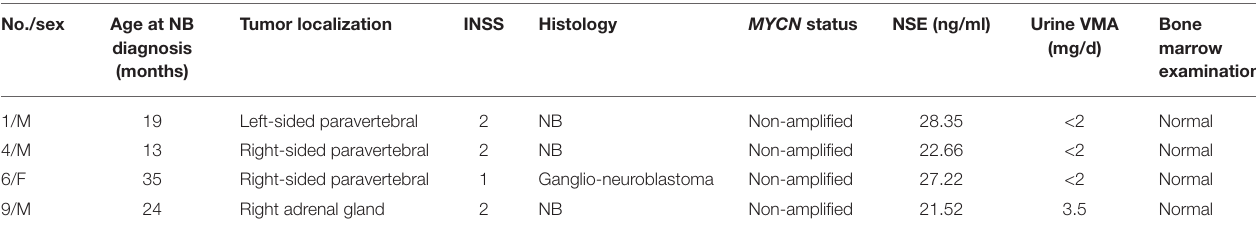
TABLE 1 | Clinical and histological characteristics of NB patients with OMS. No./sex